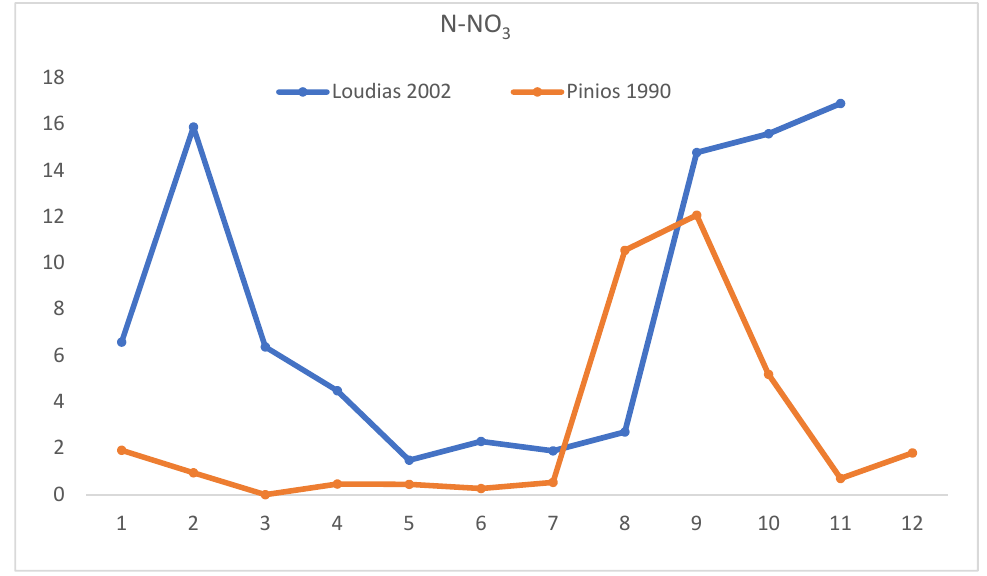
Figure 3. Monthly nitrate (N-NO 3 , mg/L) variation in the Loudias and Pinios rivers during hydrologically distinct years.